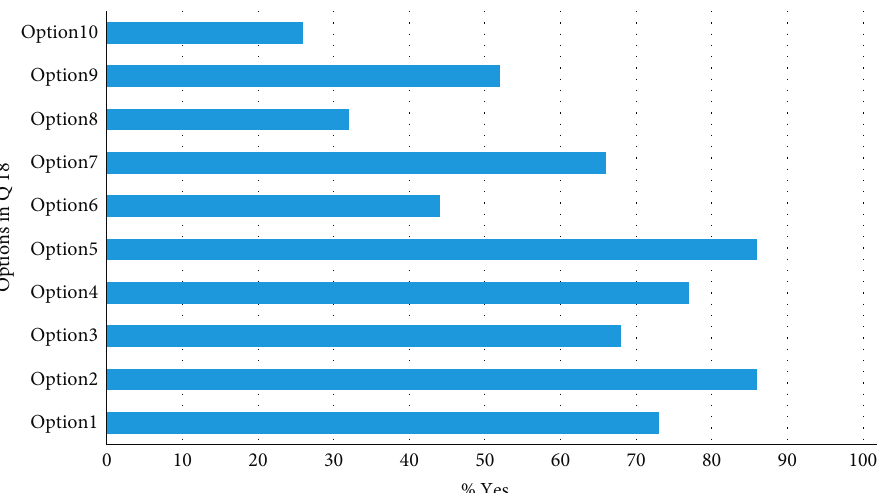
Figure 2: Percent of responses on different options given for question no.18 of questionnaire (Annex A (Table 2)). Option 1: contribution to